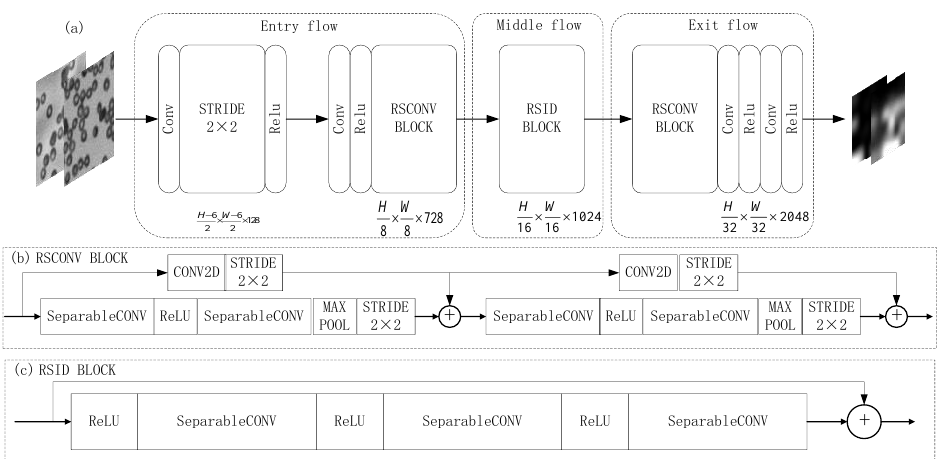
Figure 4. Migration Xception base network layer network model framework: ( a ) schematic diagram of the base network layer network model; ( b ) RSCONV BLOCK network structure module; ( c ) RSID BLOCK network structure module.